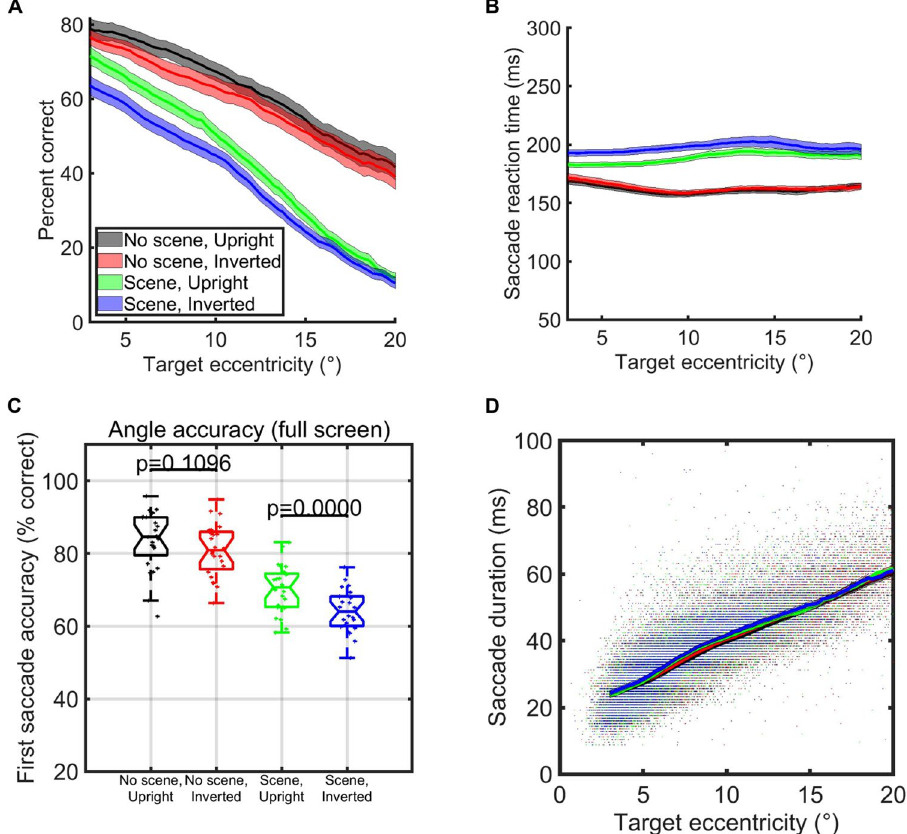
Figure 2. Eccentricity and saccade timing analyses over the entire screen (Experiment 1). ( A ) Percent of trials that the first saccade after stimulus onset landed on the face at each eccentricity, colored according to experimental condition (see legend). Error bars for each condition correspond to the standard error of the mean of the subject averages when targets were within 2° windows surrounding each point on the x-axis. ( B ) Mean saccade reaction time according to each eccentricity of the stimulus. Error bars correspond to standard error of the mean of the subject averages within 2° windows for that condition surrounding each point on the x-axis. Red and black curves overlap to some extent. ( C ) Angle accuracy of the first saccade after stimulus onset. Here, we counted the first saccade after stimulus onset as accurate whenever its angle was within π /8 radians of the angle of the face with respect to the eye position at the start of the trial. ( D ) Scatter plot for correct trials comparing target eccentricities and saccade durations according to condition (colors – see legend). Shaded areas are the standard errors of the subject means of the y-axis (row variable) over all correct trials within a window of two standard deviations around each particular point on the x-axis (column